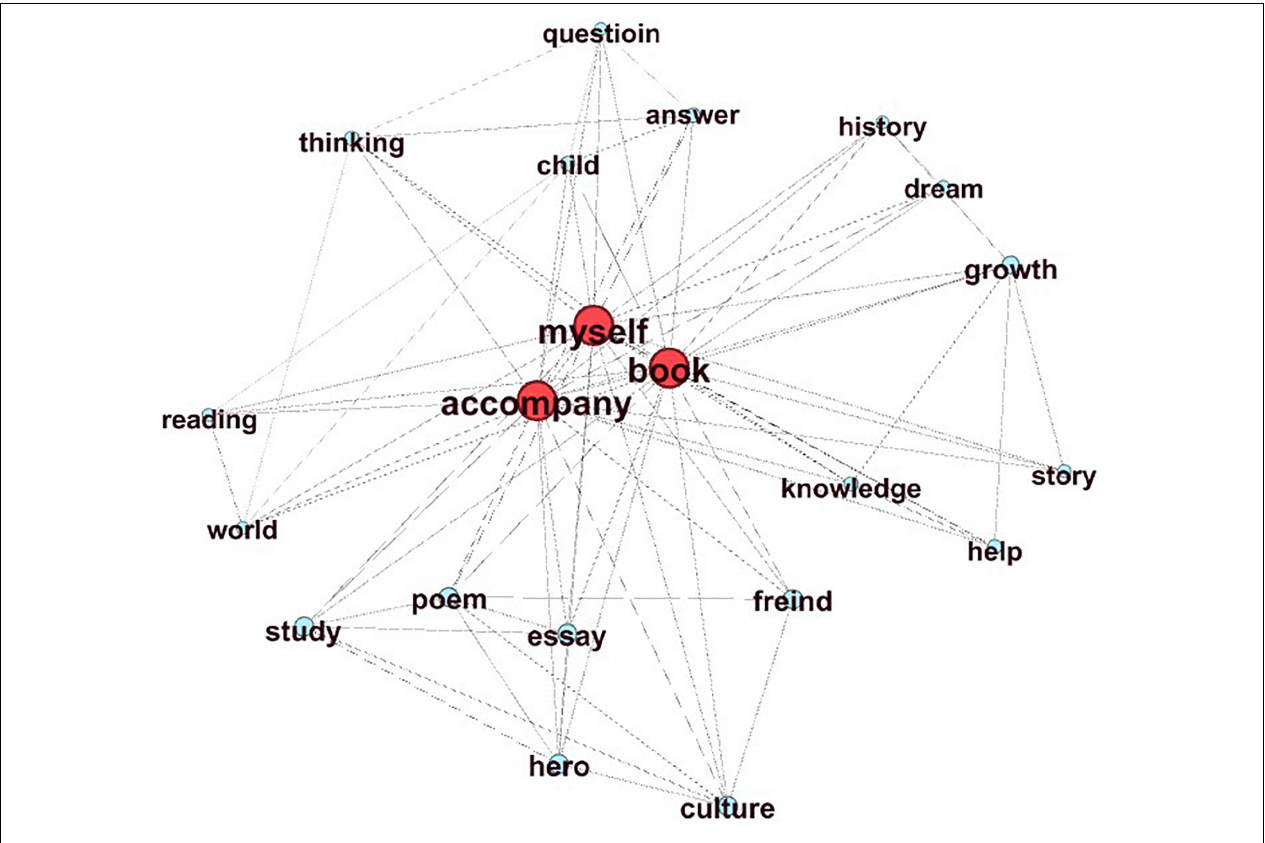
FIGURE 4 | High-level